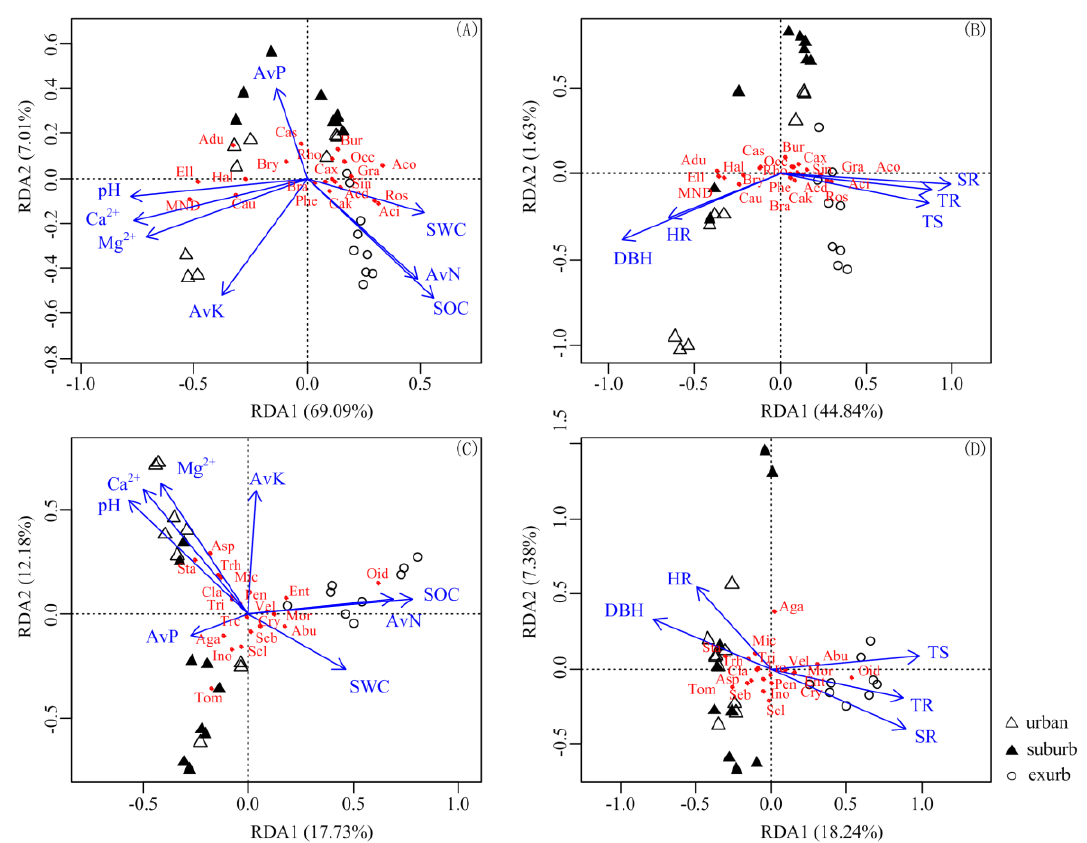
Figure 5. Redundancy analysis (RDA) plot showing influence of soil properties and plant traits on the distribution of main genera in soil bacterial ( A and B ) and fungal ( C and D )